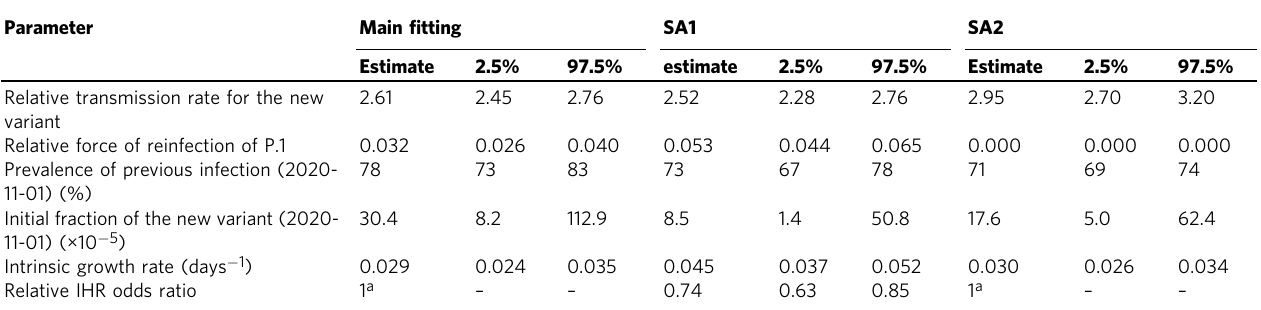
Table 2 Summary of the fi tted parameters and respective con fi dence intervals considering the entire period, November 1, 2020 to January 31, 2021 maintaining the same pathogenicity of the previous